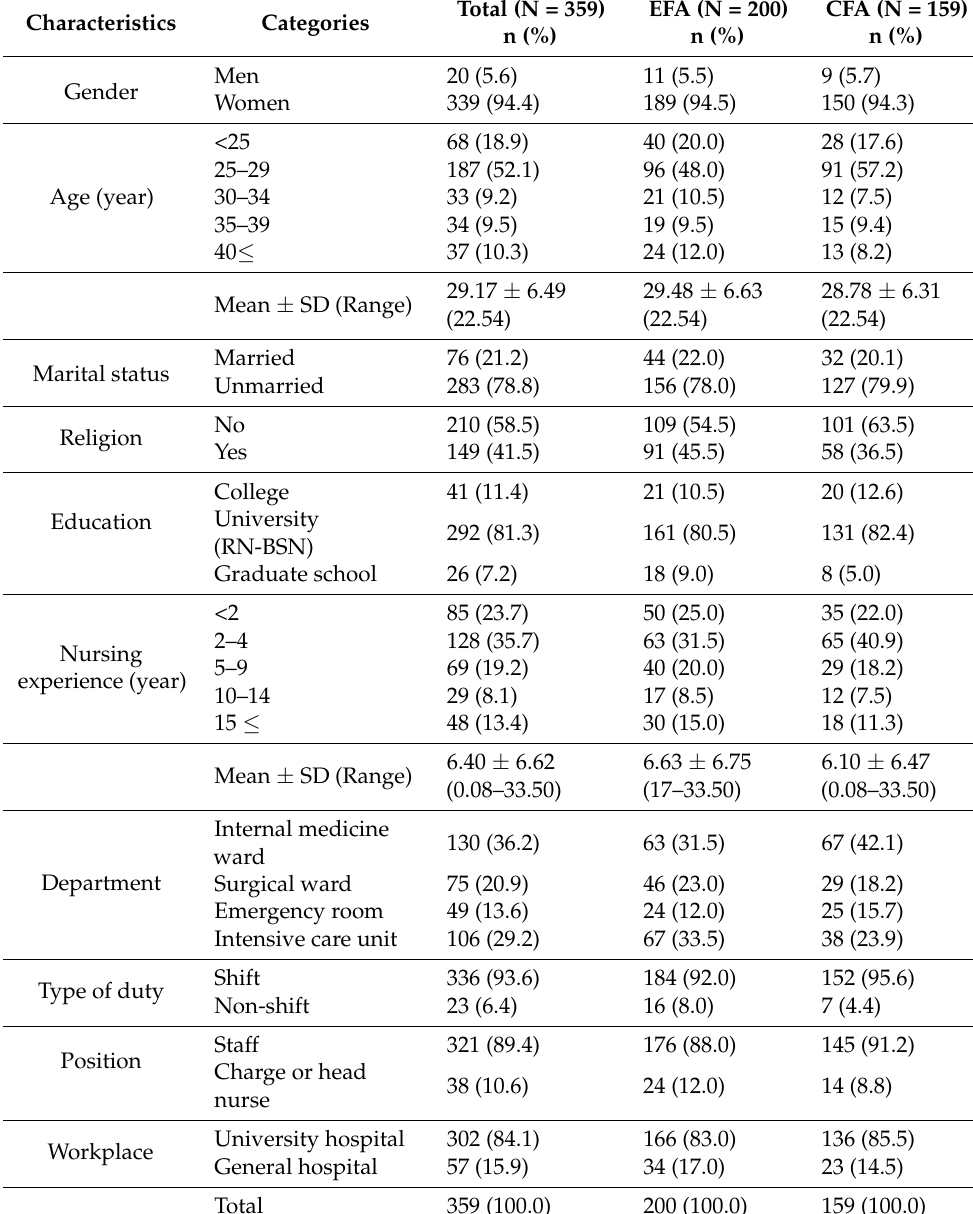
Table 1. Demographic characteristics of